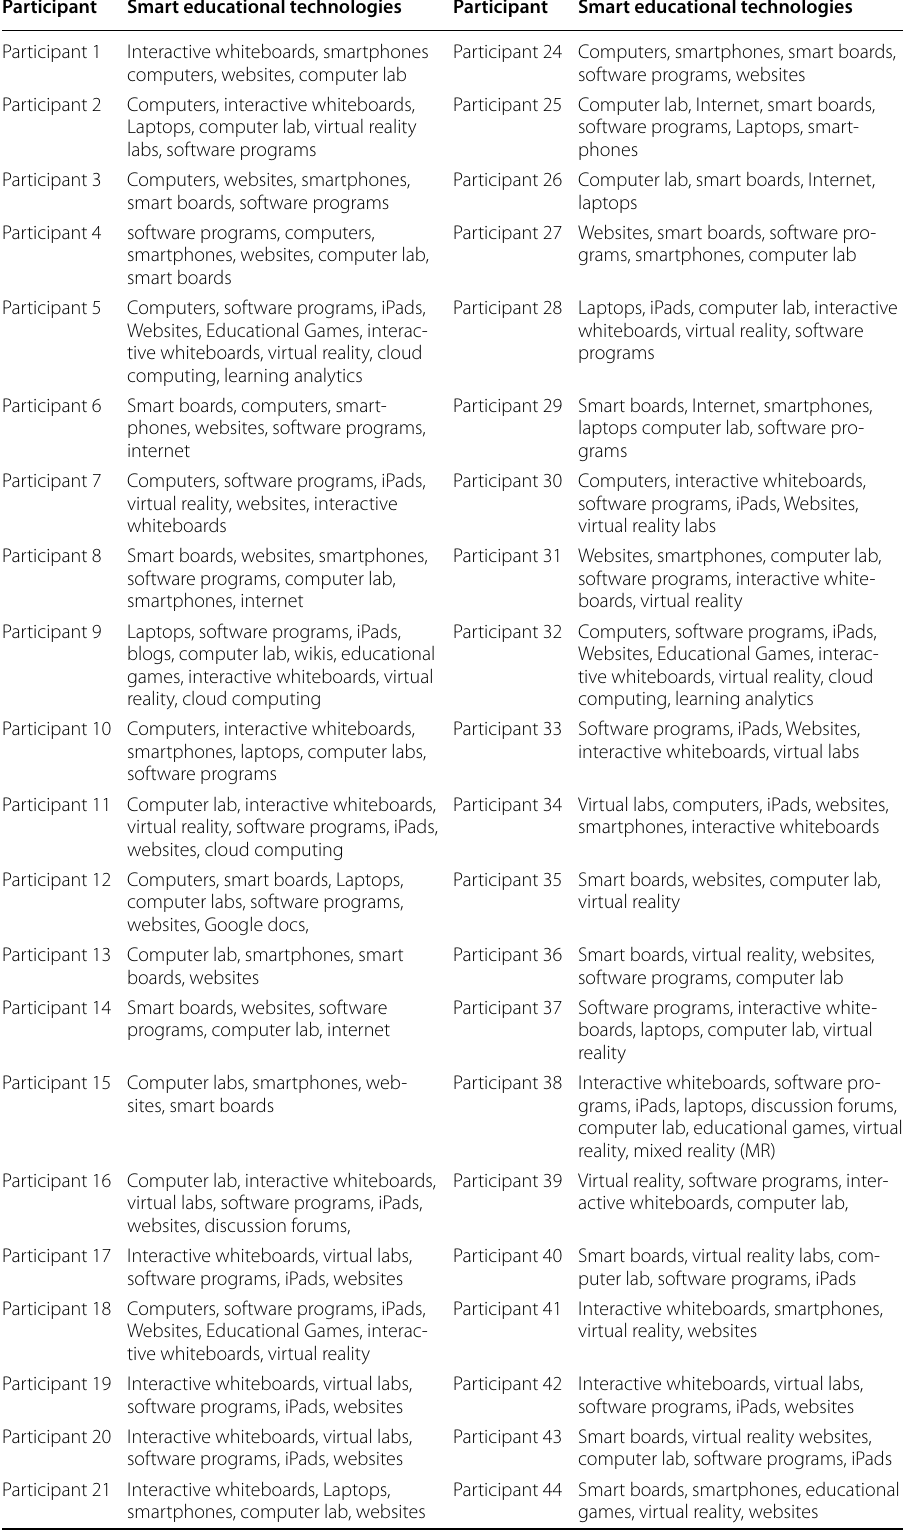
Table 4 Smart educational technologies used by